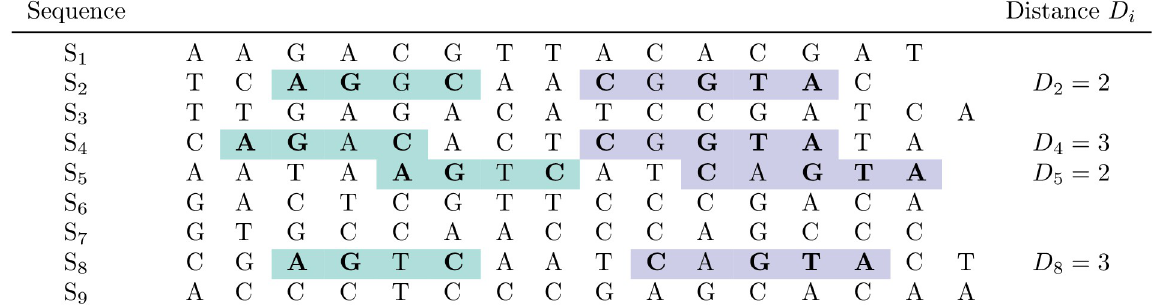
Fig 3. Two quartet blocks B 1 and B 2 (in green and purple) with respect to binary patterns 1101 and 10111, and with the matching spaced words ‘A G � C’ and ‘C � G T A’, respectively, involving the same four sequences S 2 , S 4 , S 5 , S 8 . The distances between B 1 and B 2 in these sequences are D 2 = D 5 = 2 and D 4 = D 8 = 3. In the sense of maximum parsimony , these distances would support the quartet topology S 2 S 5 | S 4 S 8 , since this topology would require only one insertion/deletion (indel) event to explain the distances D for the involved sequences would require two indel events. With our terminology, we say that this topology is strongly supported by the four distance values